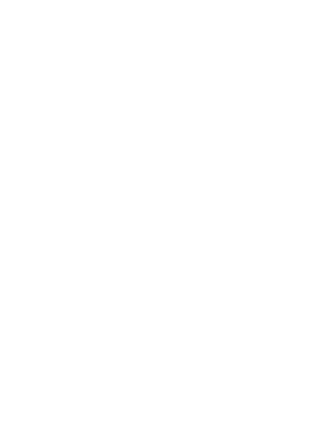
FIGURE 3 | A 3-step diagnostic work fl ow based on tumor markers for patients